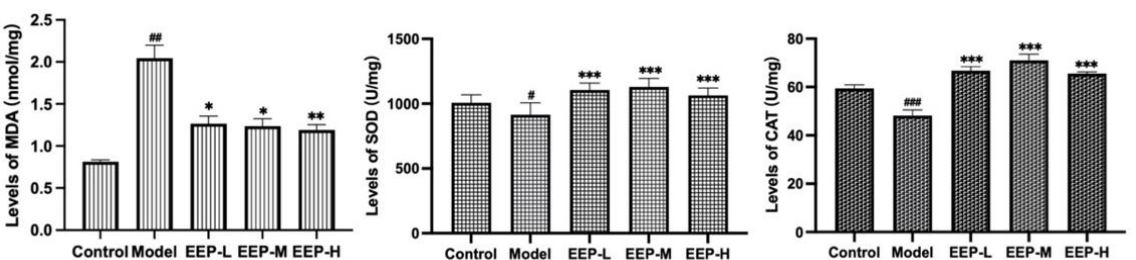
Figure 4. Effect of EEP treatment on antioxidative markers in hyperthyroidism mice. Data are presented as mean ± SEM ( n = 8). # p < 0.05, ## p < 0.01 and ### p < 0.001 versus Control; * p < 0.05, ** p < 0.01 and *** p < 0.001 versus Model.